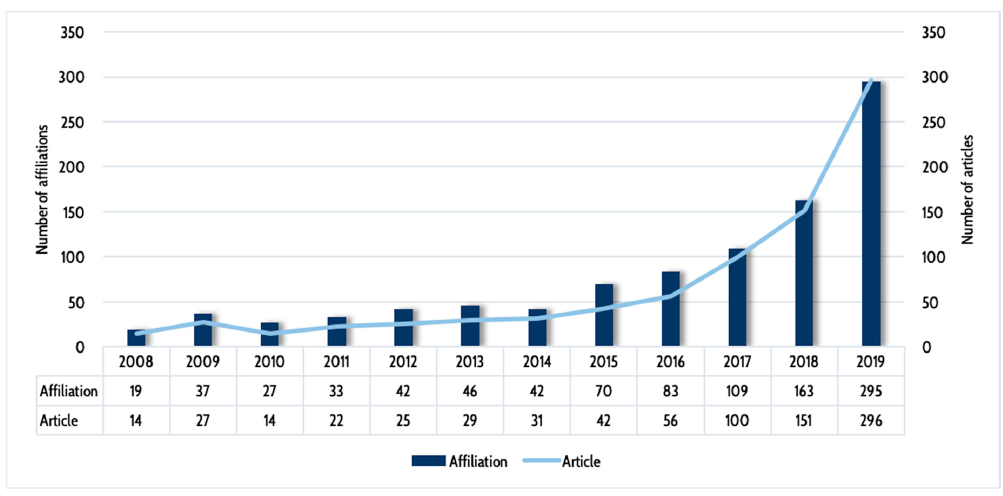
Figure 7. Numbers of affiliations and articles in domestic collaboration during the period from 2008–2019 (Last updated 30 April 2020).